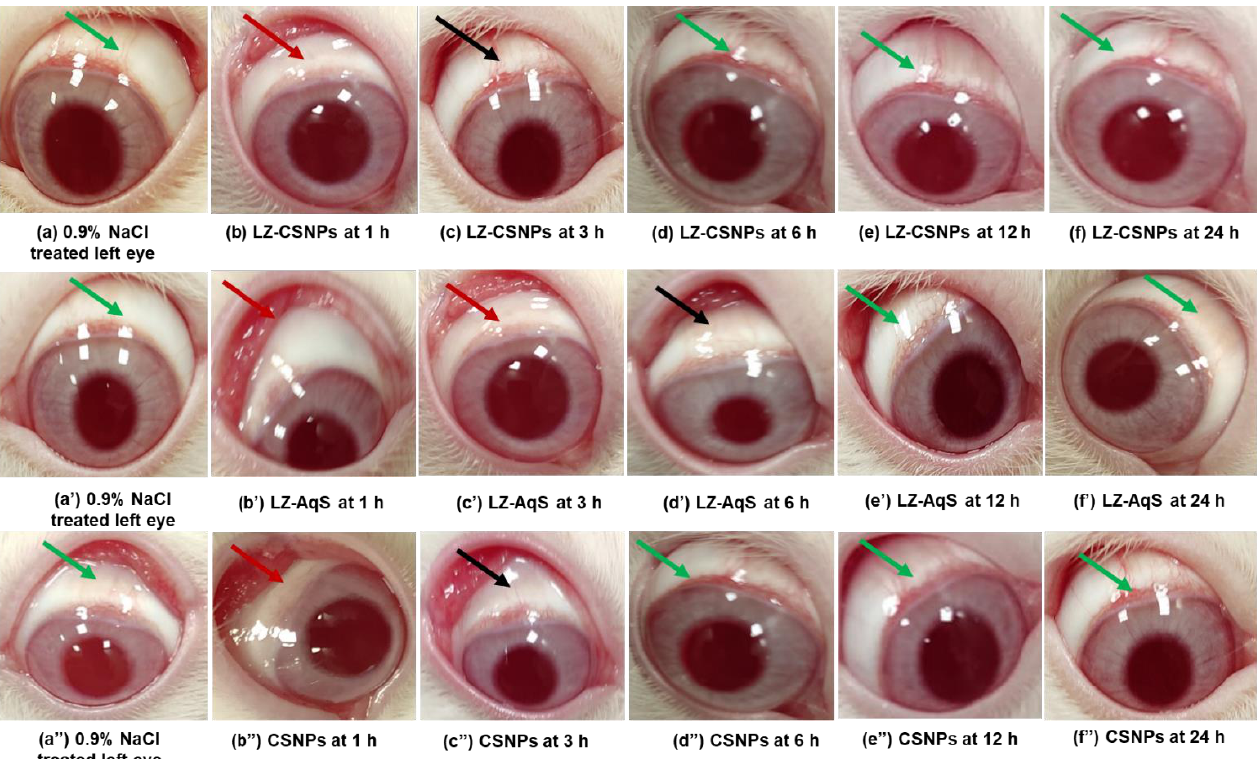
Figure 5. Eye images captured during irritation study. Representative images of normal saline treated eyes ( a ), ( a’ ) and ( a’’ ) (green arrows). Post topical application of LZ – CSNPs at 1 h ( b ); (red arrows) at 3 h (black arrows) ( c ); at 6 h ( d ); at 12 h ( e ) and at 24 h ( f ), (green arrow) whereas the post topical application of LZ – AqS at 1 h ( b’ ) (red arrows); at 3 h ( c’ ) red arrows); at 6 h ( d’ ); at 12 h ( e’ ) and at 24 h ( f’ ) (green arrow) and post topical application of CSNPs at 1 h ( b” ) (red arrows); at 3 h ( c” ) (black arrows); at 6 h ( d” ); at 12 h ( e” ) and at 24 h ( f” ) (green arrow).